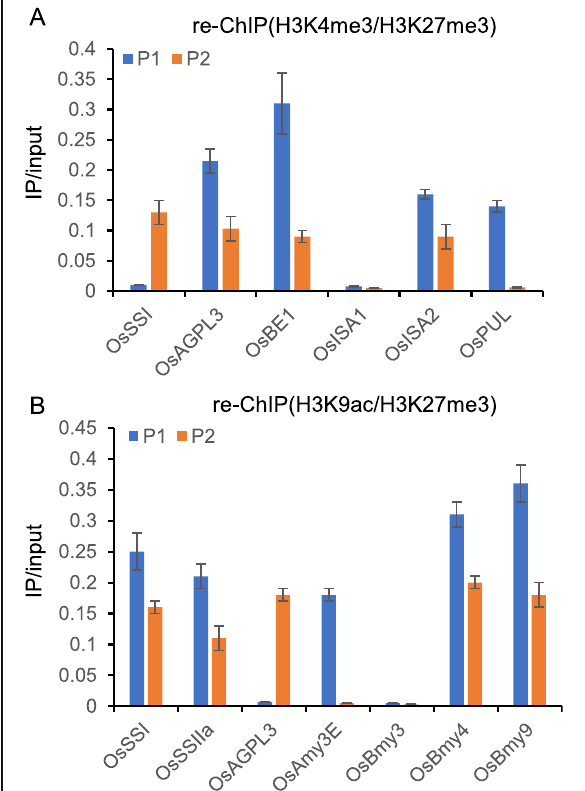
Fig. 7 H3K4me3-H3K27me3 and H3K9ac-H3K27me3 bivalent chromatin state on some starch metabolism genes. Re-ChIP analysis of H3K4me3-H3K27me3 ( a ) and H3K9ac-H3K27me3 ( b ) of starch synthase genes and amylase genes in WT seeds at 3 DAP. H3K4me3 and H3K9ac enrichment an the 5 ′ transcriptional start site (TSS) (P1) and H3K27me3 enrichment at 5 ′ end of the gene body (P2) were detected by quantitative. Each q-PCR assay was repeated three times. Bars = mean ± SD from three technical